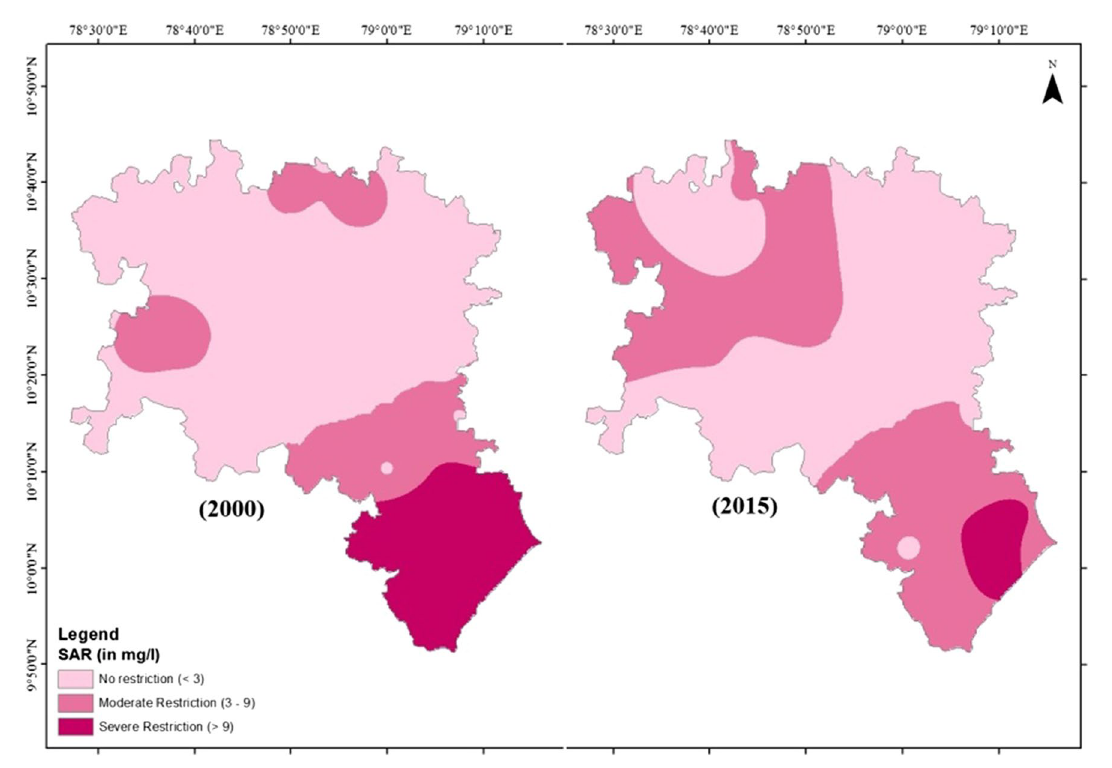
Fig. 8 Spatial distribution of SAR (2000 and 2015)